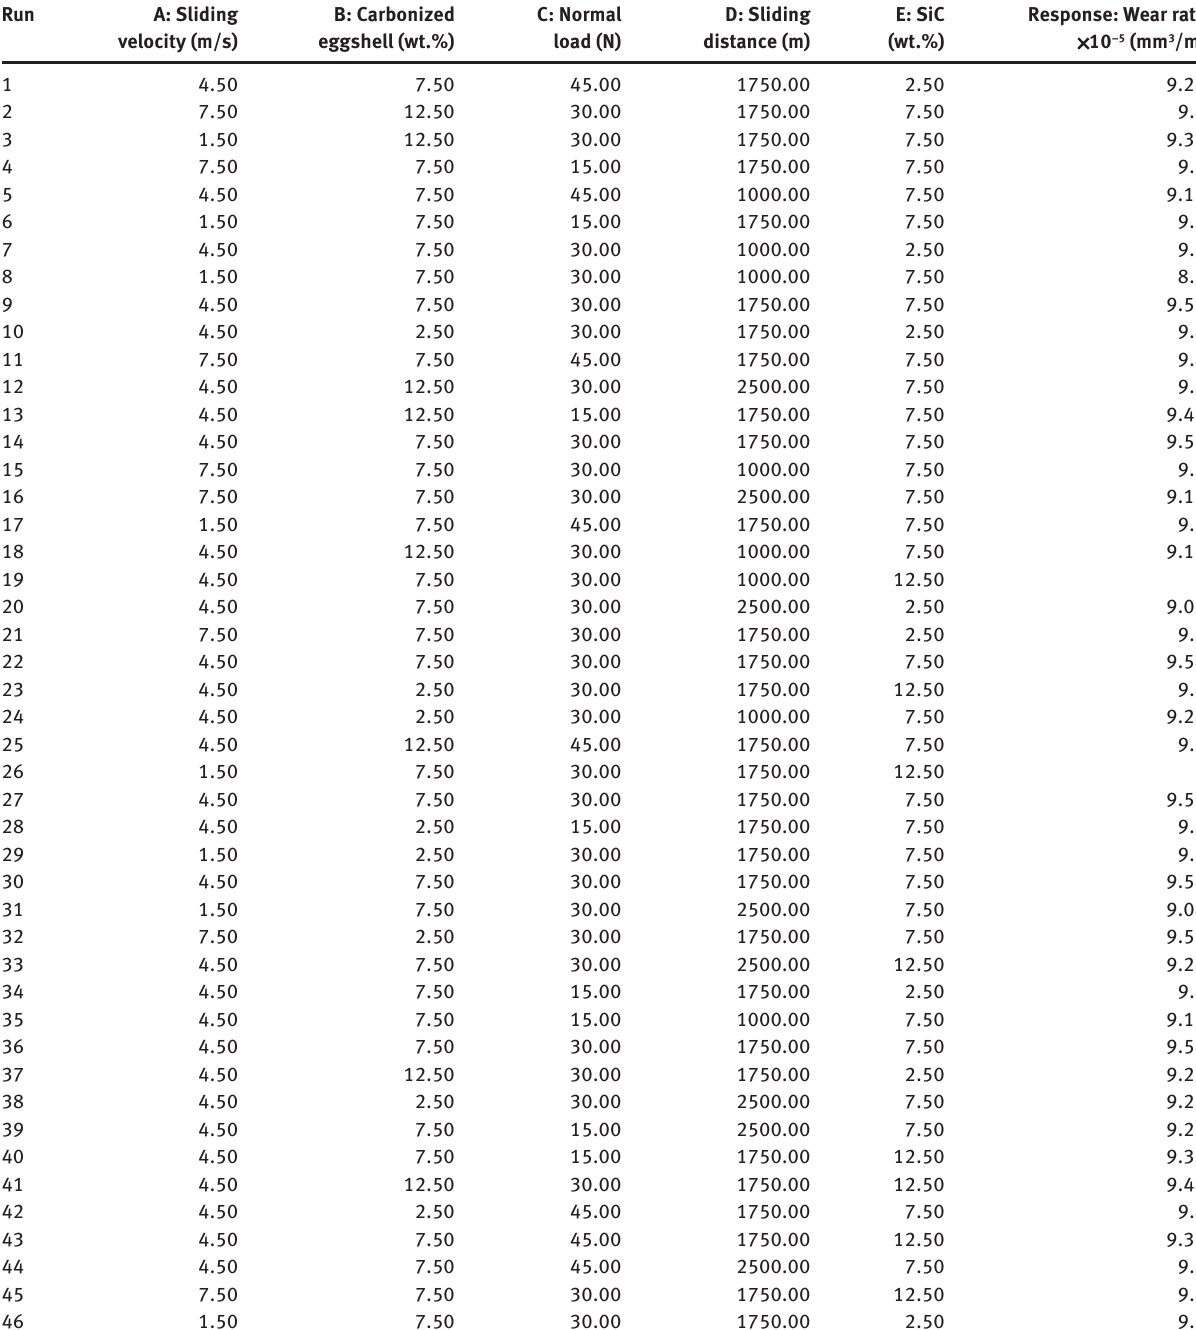
Table 3: Design matrix for wear rate. Run